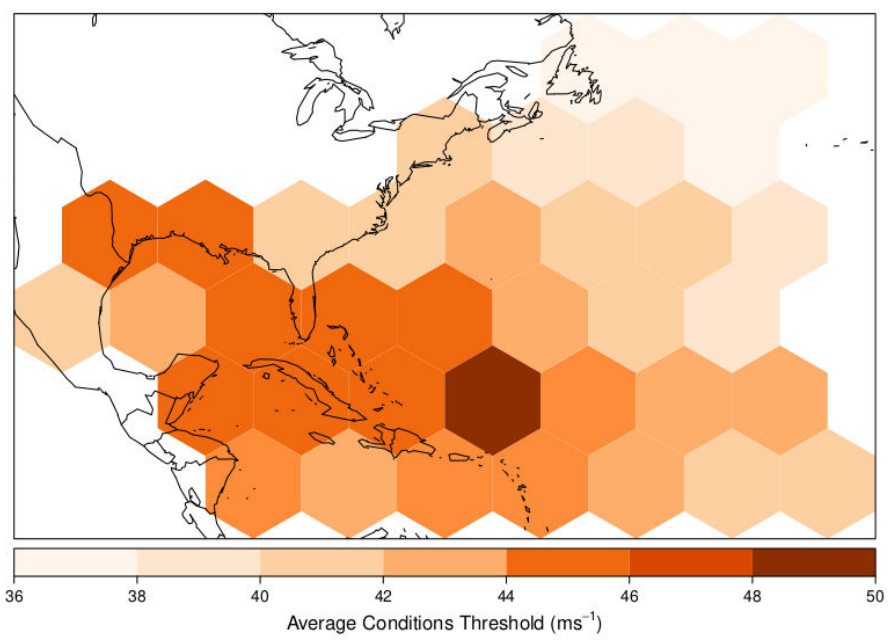
Figure 5. The historical 50th percentile wind speed used as the extreme value model threshold in ms − 1 .